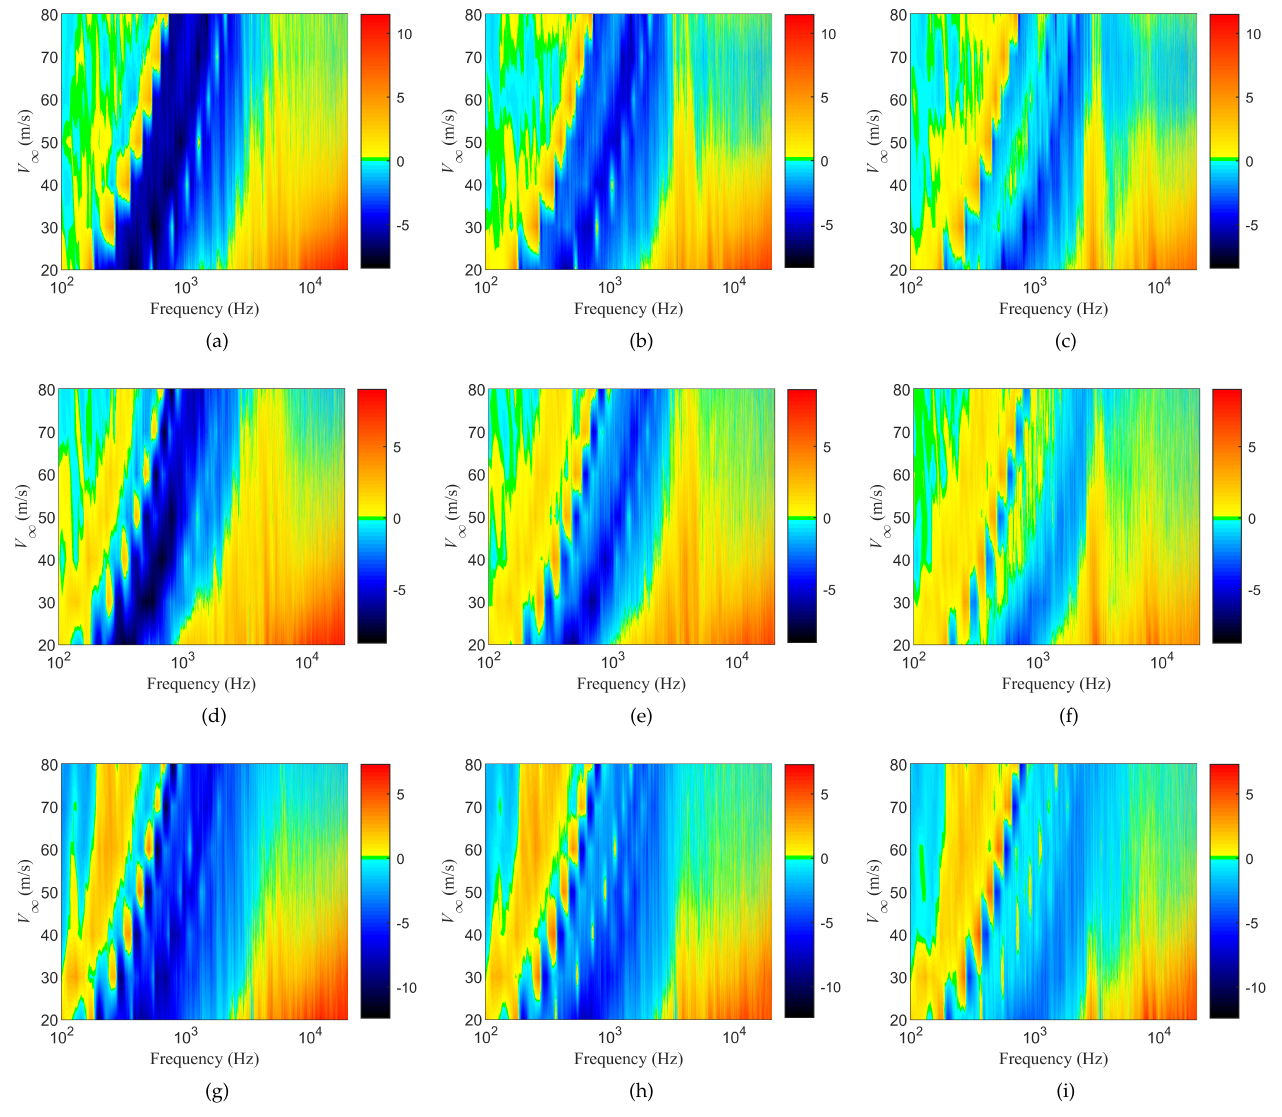
Figure 9. ∆ SPL for different percentages of porous treatment: ( a ) X40Y40Z40, L = 100 mm, α = 0 ◦ ; ( b ) X40Y40Z00, L = 100 mm, α = 0 ◦ ; ( c ) X40Y00Z00, L = 100 mm, α = 0 ◦ ; ( d ) X40Y40Z40, L = 200 mm, α = 0 ◦ ; ( e ) X40Y40Z00, L = 200 mm, α = 0 ◦ ; ( f ) X40Y00Z00, L = 200 mm, α = 0 ◦ ; ( g ) X40Y40Z40, L = 200 mm, α = 10 ◦ ; ( h ) X40Y40Z00, L = 200 mm, α = 10 ◦ ; and ( i ) X40Y00Z00, L = 200 mm, α = 10 ◦